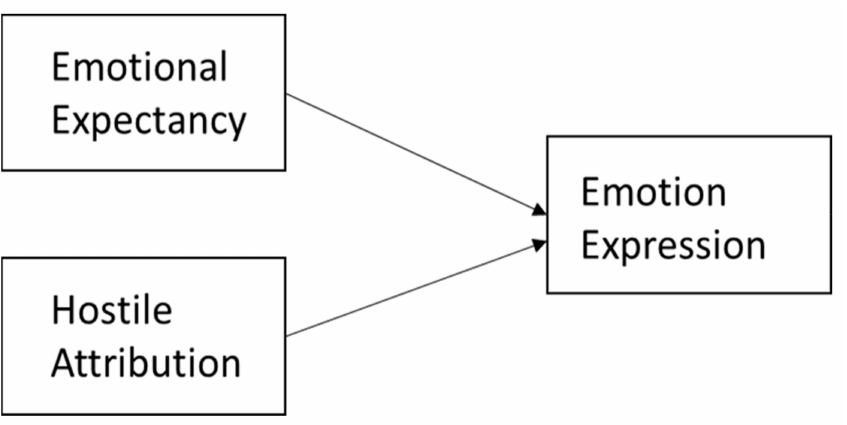
Figure 1. Illustration of constructs